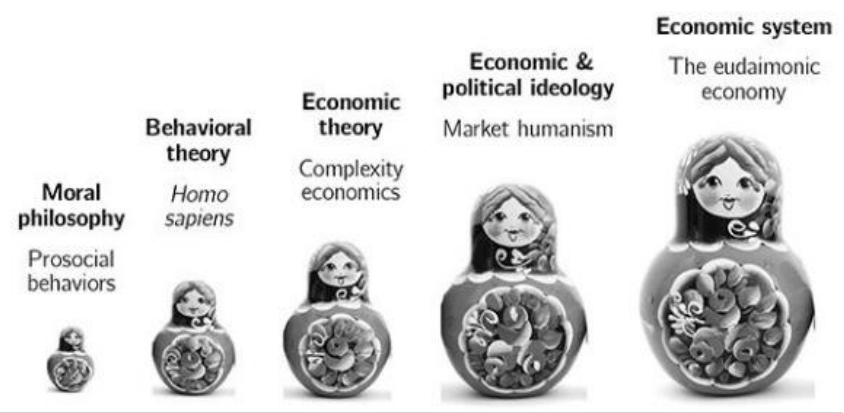
Figure 2. Beinhocker's suggested economic order